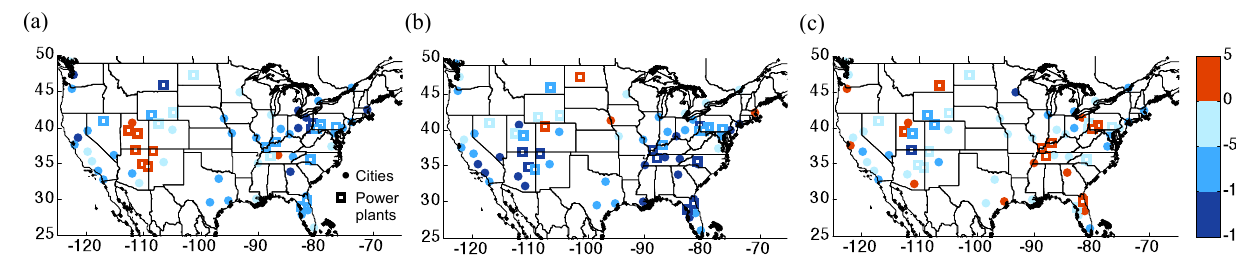
Fig. 5. Percent change per year in OMI BEHR NO 2 column for (a) 2005–2007, (b) 2007–2009, and (c) 2009–2011 for major cities (dots) and power plants (squares) in the